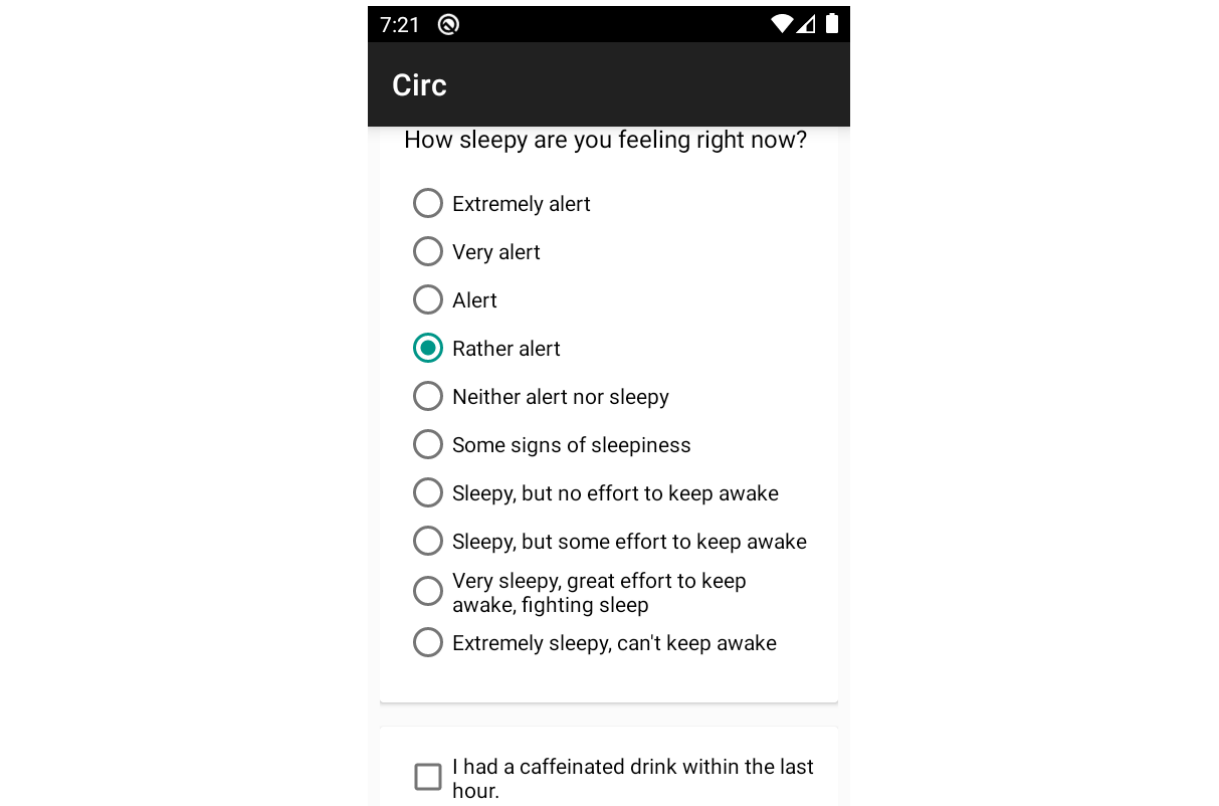
Figure 1. Screenshot of the Karolinska Sleepiness Scale and caffeination